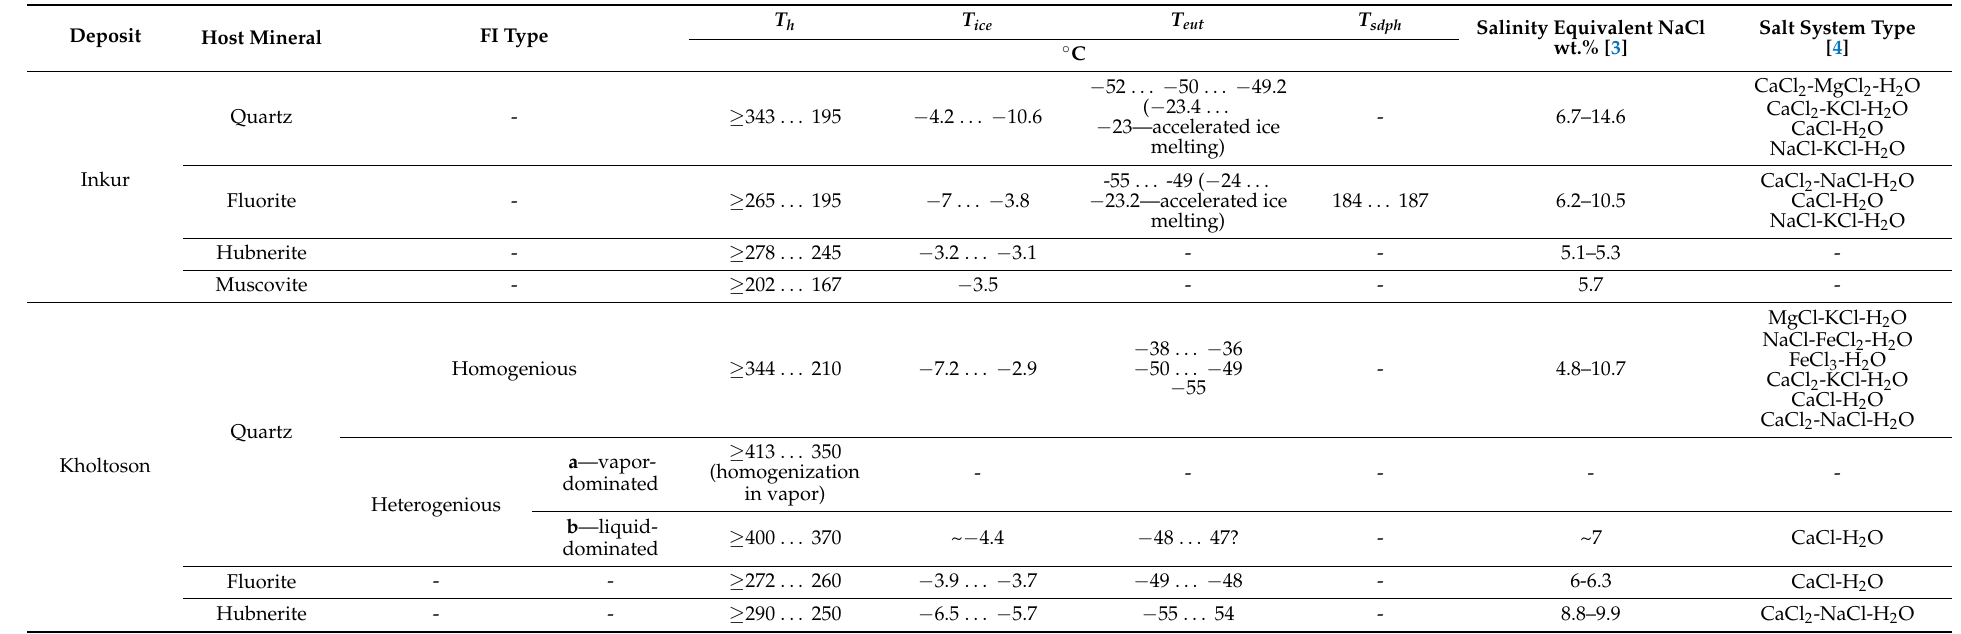
Table 6. Microthermometry summary table of fluid inclusions in the minerals of the Inkur and Kholtoson